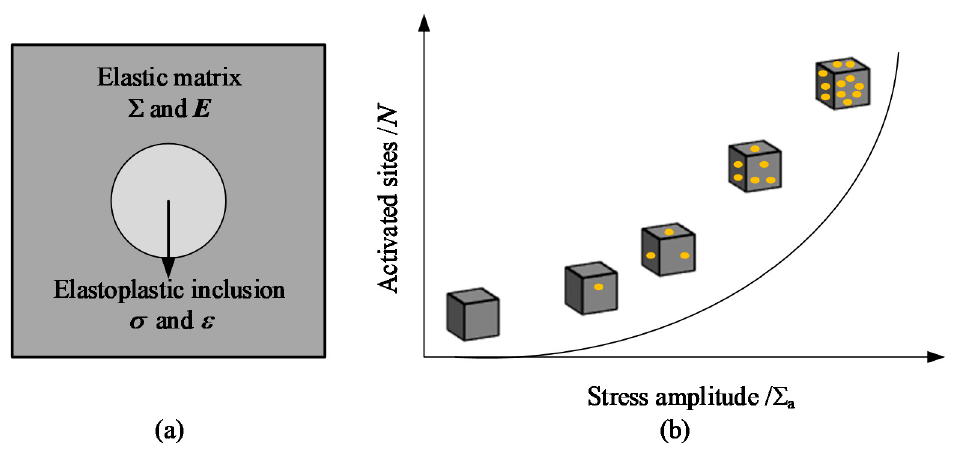
Figure 1. Schematic representation of representative volume element (RVE) model: ( a ) RVE model; ( b ) Activated sites within an elastoplastic inclusion during high-cycle fatigue (HCF).